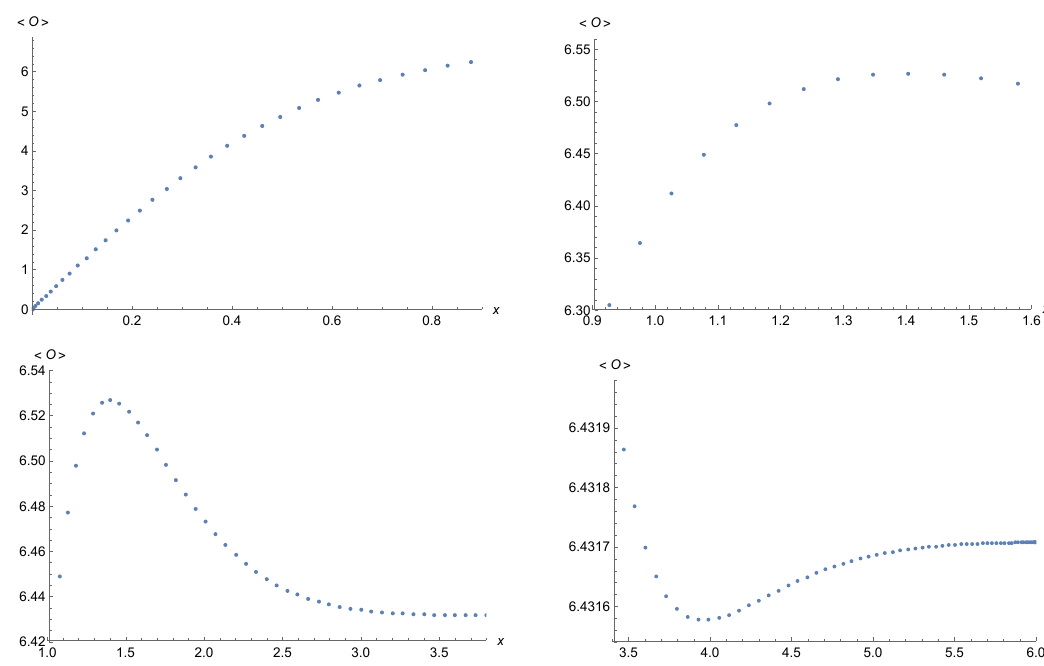
Figure 7 . The magni(cid:12)ed order parameter, at (cid:22) = 5 : 5, as a function of x from 0 to 6 (half plot